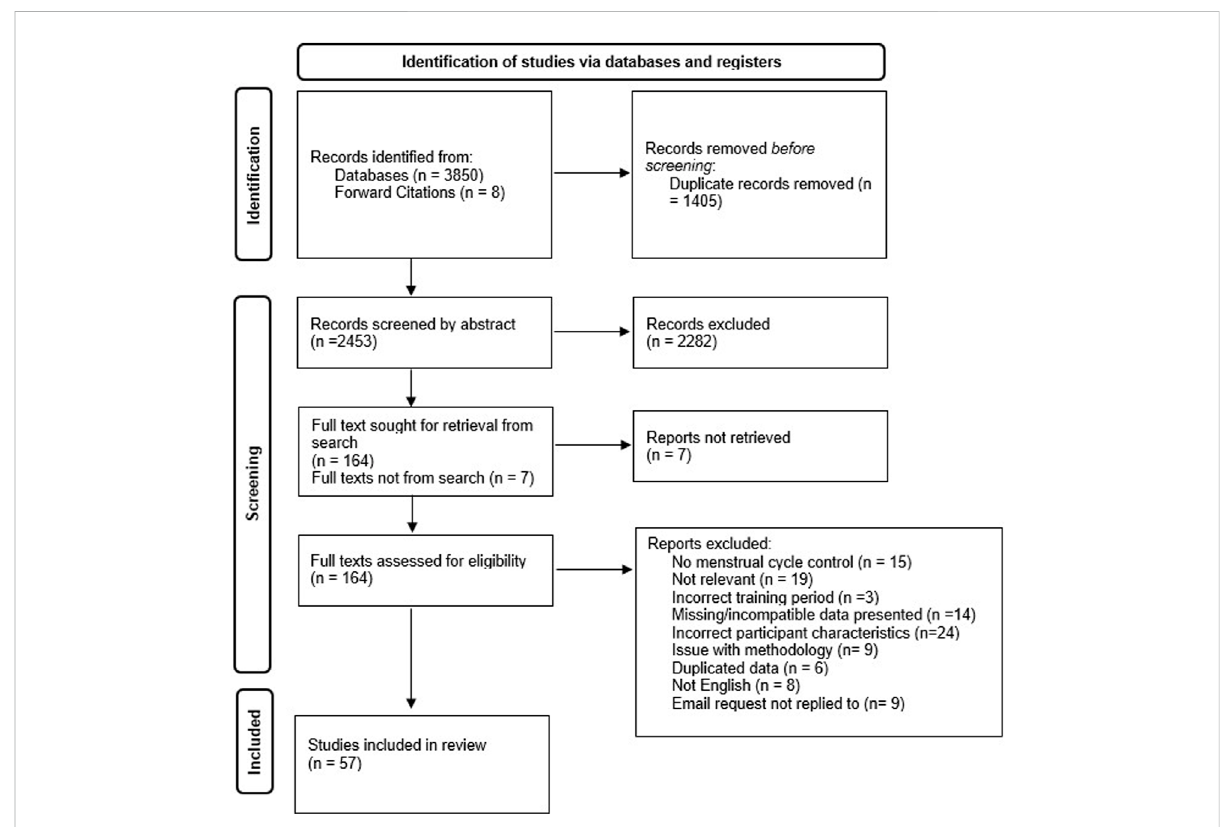
FIGURE 1 Systematic literature search PRISMA (Preferred Reporting Items for Systematic Reviews and Meta-Analyses) fl ow